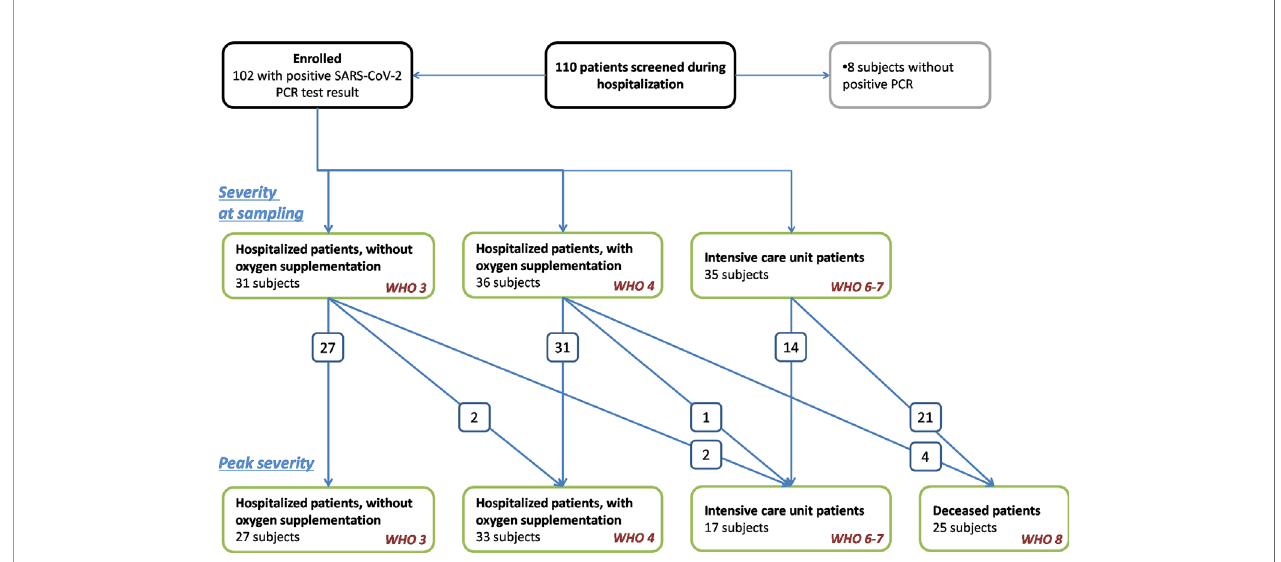
FIGURE 1 | Study fl ow chart. Screening and enrollment of patients with SARS-CoV-2 infection. Only hospitalized patients with PCR-con fi rmed SARS-CoV-2 infection were enrolled into the study. Clinical and treatment data indicating severity of COVID-19 were extracted from electronic hospital records, and patients were strati fi ed according to severity in two time-points: fi rst, at the time point when sampling for complement analysis was done, and second, according to the worst clinical condition (or death). Arrows and numbers indicate the number of patients whose COVID-19 progressed, i.e. these patients progressed to an advanced severity group (or died) after sampling. De fi nitions for severity groups were based on WHO protocol (31). Note, that extra-corporeal membrane oxygenator treatment, non-invasive ventilation, or high- fl ow oxygen therapy was not used for patients in this study, therefore, there is no “ WHO 5 ” severity group in this study. Patients, who were registered to donate convalescent plasma in a clinical trial (32), and who had evidence of past SARS-CoV-2 infection but did not require hospital treatment were sampled in convalescent phase formed the patient control